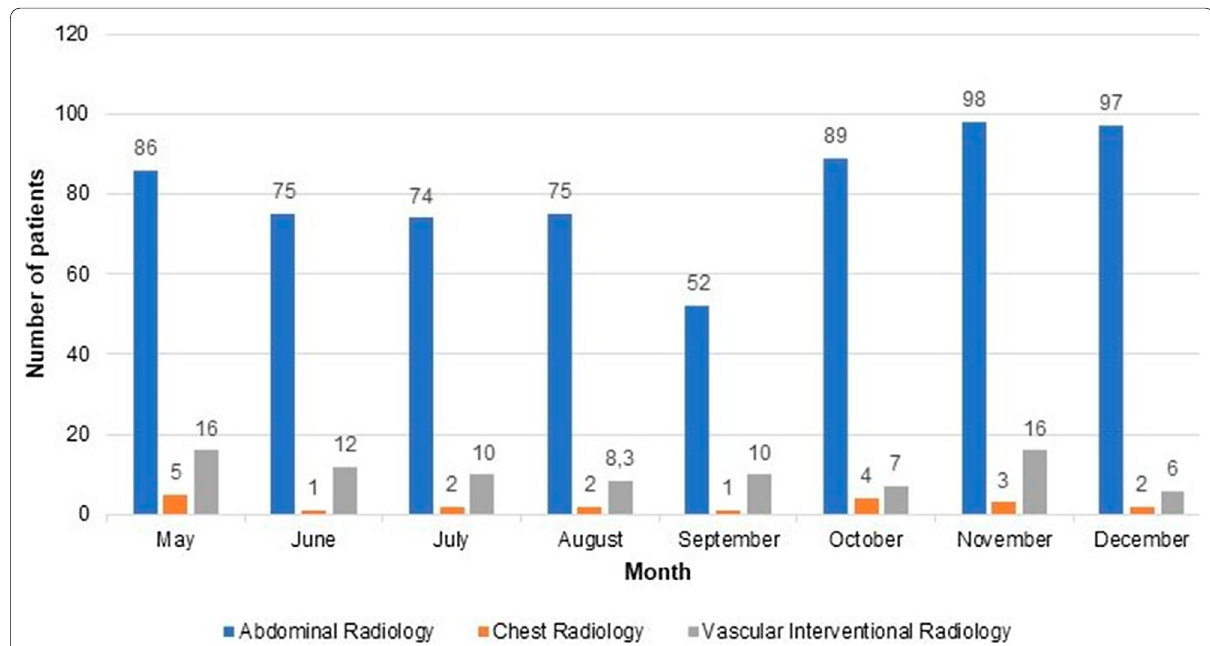
Fig. 1 Admitted patients in the Radiology Day Unit in 2018. Number of patients admitted to the Radiology Day Unit during the last 8 months of 2018 distributed by the corresponding section